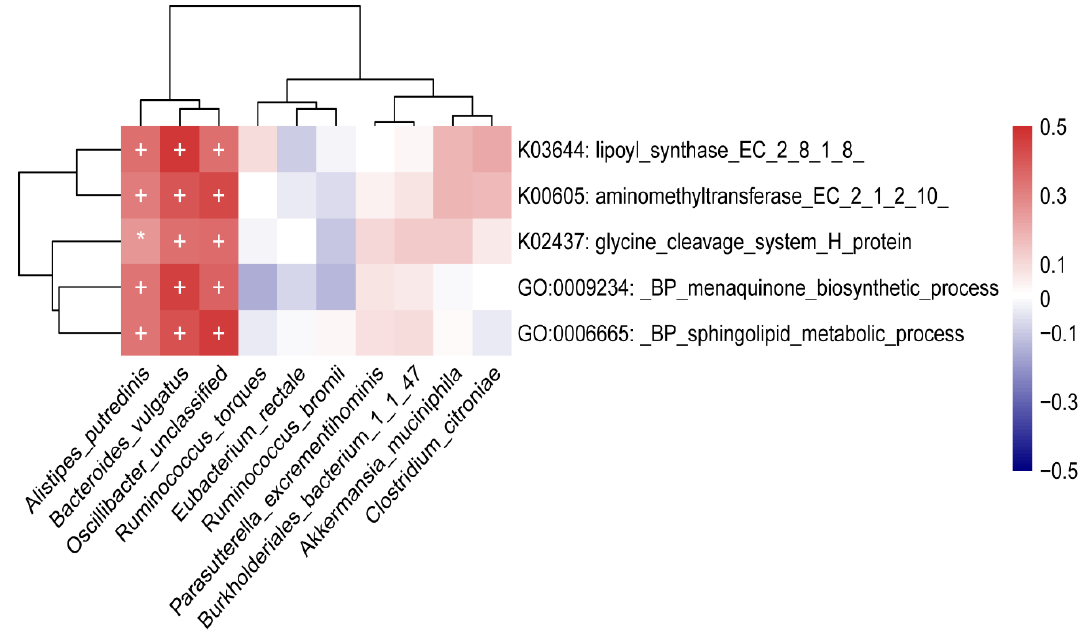
Figure 6. Heatmap of Spearman correlation between different species and function modules be- tween case and control groups. Positive correlations are indicated in red text and negative correla- tions are indicated in blue text. (* p < 0.05; + p < 0.01).